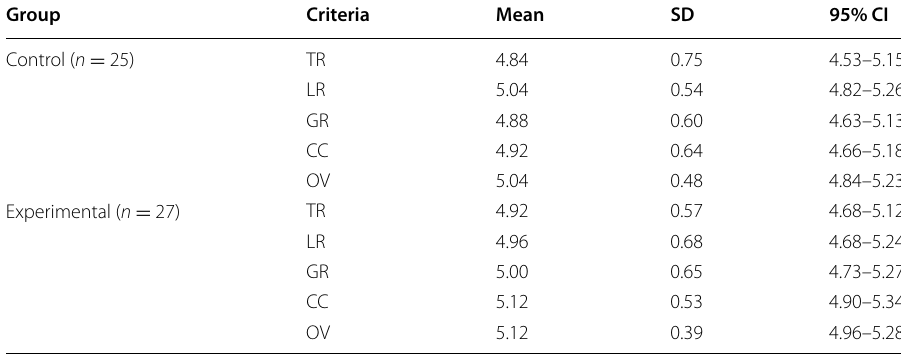
Table 4 Descriptive statistics for the pretest Group Criteria